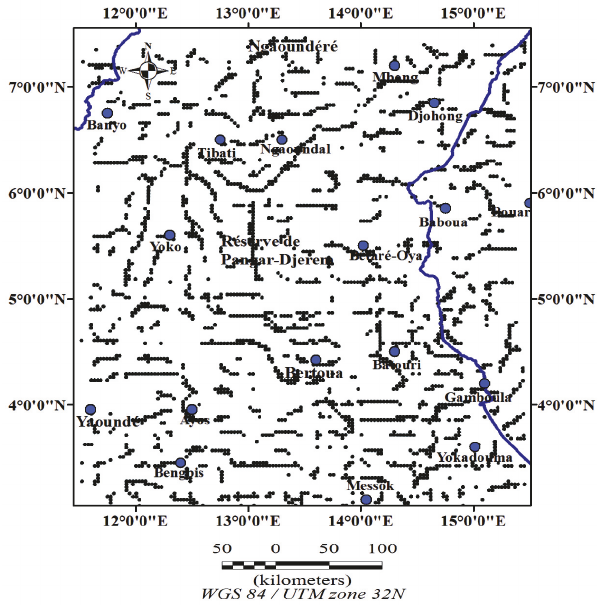
Figure 7: Maxima of the horizontal gradient magnitude map upward at 4